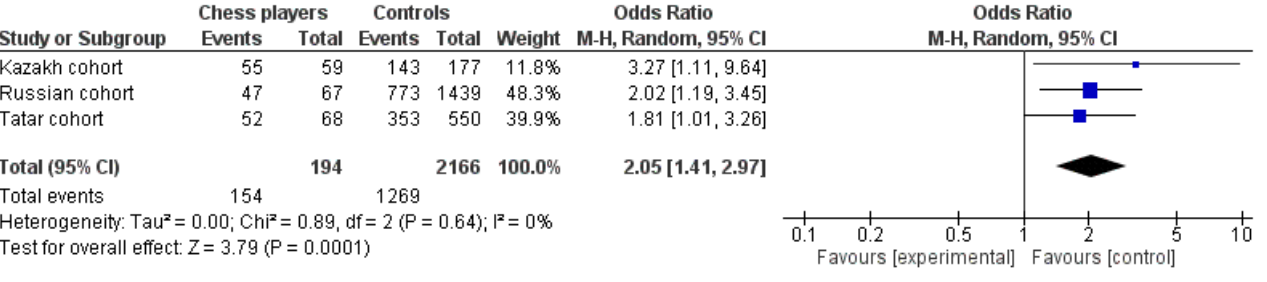
Figure 2. Meta-analysis for association studies for the KIBRA gene and chess player status. The prevalence of the rs17070145 CT/TT genotypes has been shown in chess players. The purple squares represent the ratio of CT/TT genotypes in chess players for each individual study. The black diamond represents the pooled ratio of CT/TT genotypes in all chess players and its 95% CI.